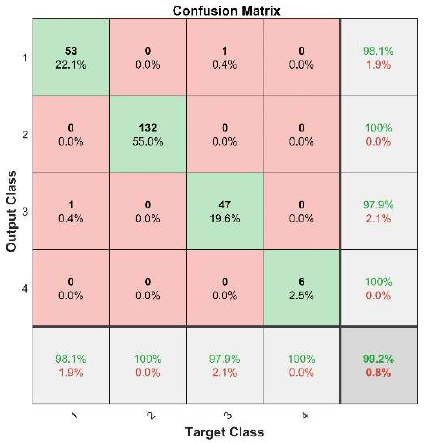
Figure 11. Confusion matrix of the results of the CAE–VMD–MPE–PSO–LSSVM method.